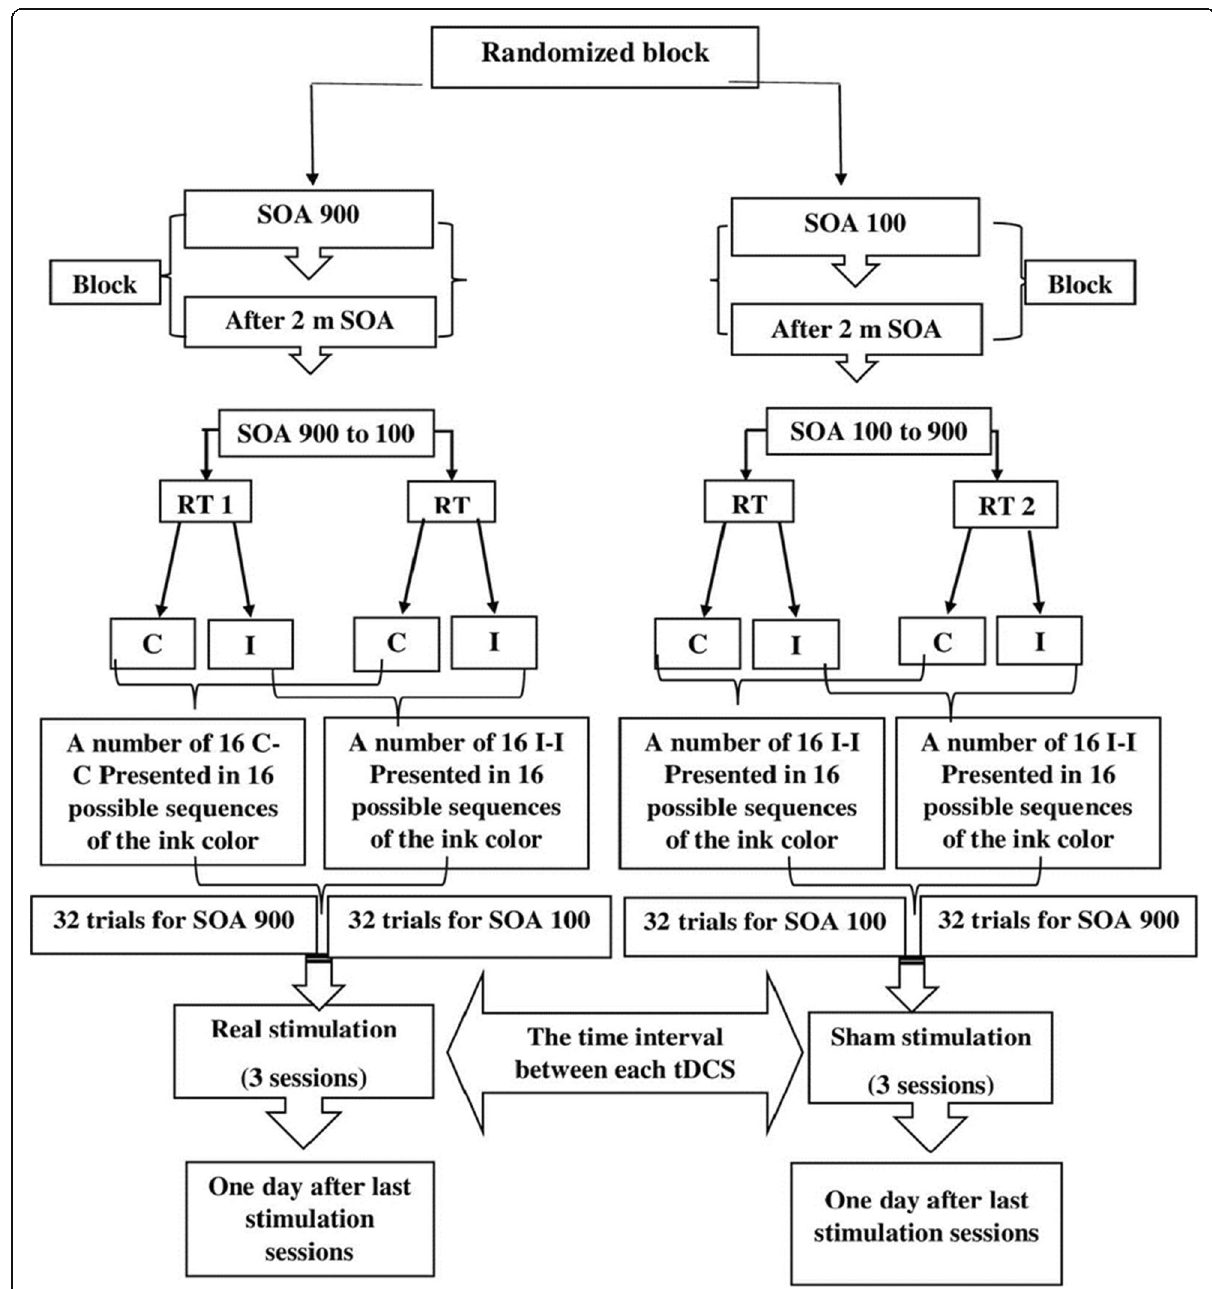
Fig. 2 Schematic design of research. SOA, stimulus onset asynchrony; RT1, first reaction time; RT2, second reaction time; C, congruent; I,